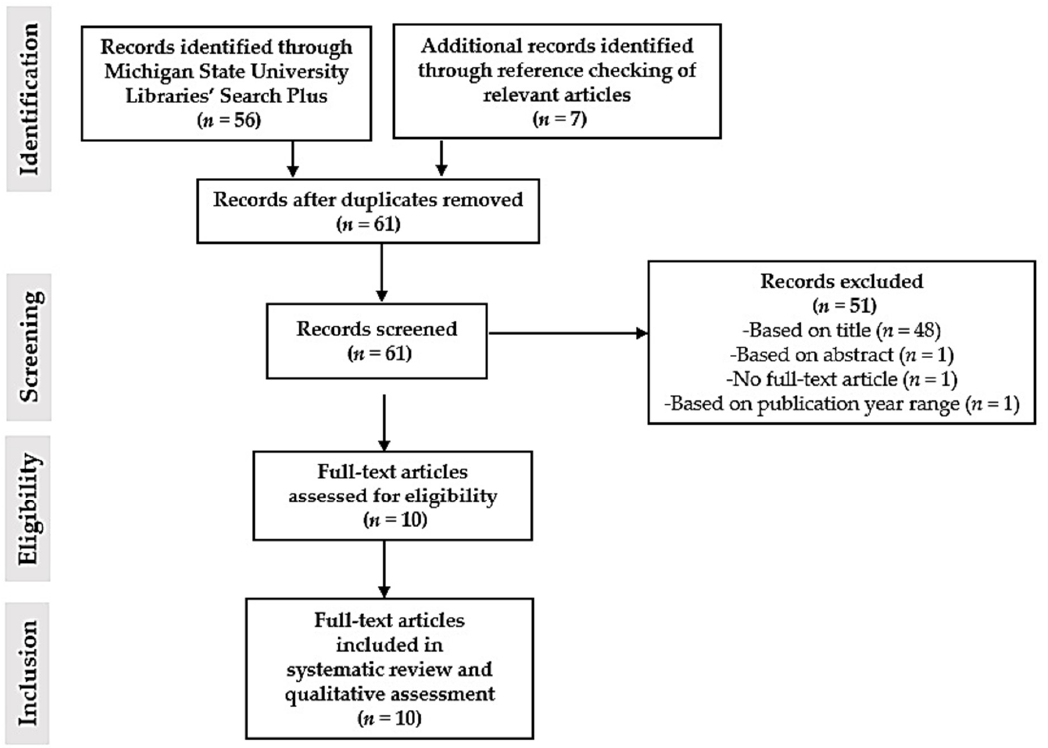
Figure 1. Literature search and selection process for studies included in this systematic review and qualitative assessment.